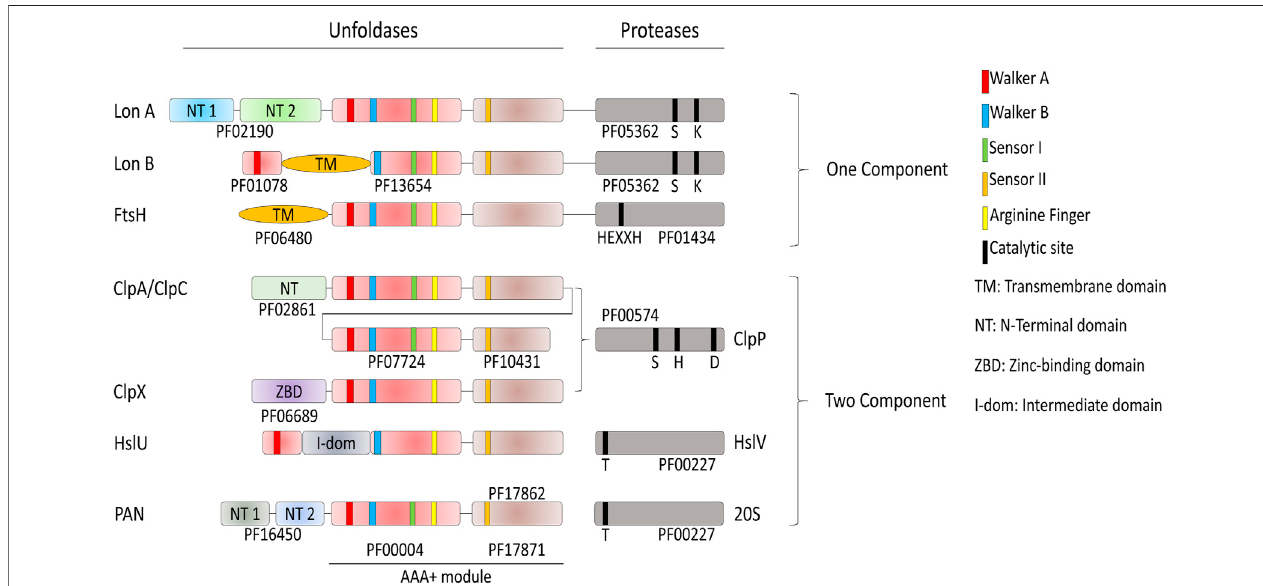
FIGURE4| DomainorganizationoftheAAA+proteasesofBacteriaandArchaea.Proteaseshavedifferentcatalyticsites;HslVandthearchaeal20Speptidaseuse an N-terminal threonine as the active-site nucleophile. Lon proteases have a lysine-serine dyad, ClpP uses a serine-histidine-arginine catalytic triad. FtsH is a Zn 2+ - dependent peptidase, with the speci fi c HEXXH motif acting as zinc ligand. The AAA+ module is composed of the conserved PFAM domains PF00004 and PF17871 for every protease if not speci fi ed by another PFAM. ClpA and ClpC are composed of two AAA+ modules.